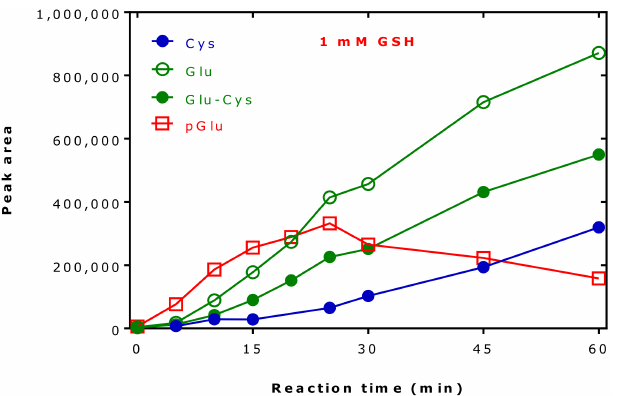
Figure 5. Peak area values of the GC-MS peaks of Cys (Peak A, m / z 207), of Glu/Glu-Cys (Peak B and C, m / z 269 and m / z 301) or pGlu (Peak C, m / z 269) from the esterification of GSH (1000 µ M) at 80 ◦ C for the indicated reaction times. Subsequent acylation was performed with PFPA (30 min, 65 ◦ C). Peaks A, B and C refer to Figure 1.